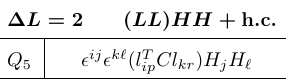
Table 4 . Dimension-five ∆ L = 2 operator Q 5 in SMEFT. There is also the Hermitian conjugate ∆ L = 2 operator Q † , as indicated by + h . c . in the table heading. Subscripts p and r are 5 − weak-eigenstate